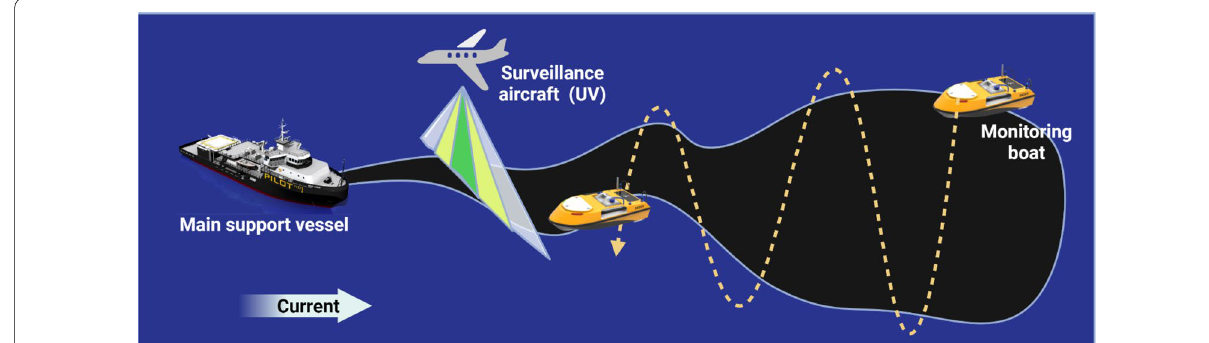
Fig. 8 A schematic diagram of the British test method. This method includes 1) the support vessel at anchor releasing and treating the oil in the tidal stream, 2) the sampling boat equipped with UV spectrofluorimetry, cruising through the oil trails and monitoring profiles of dispersed oil concentrations under the oil